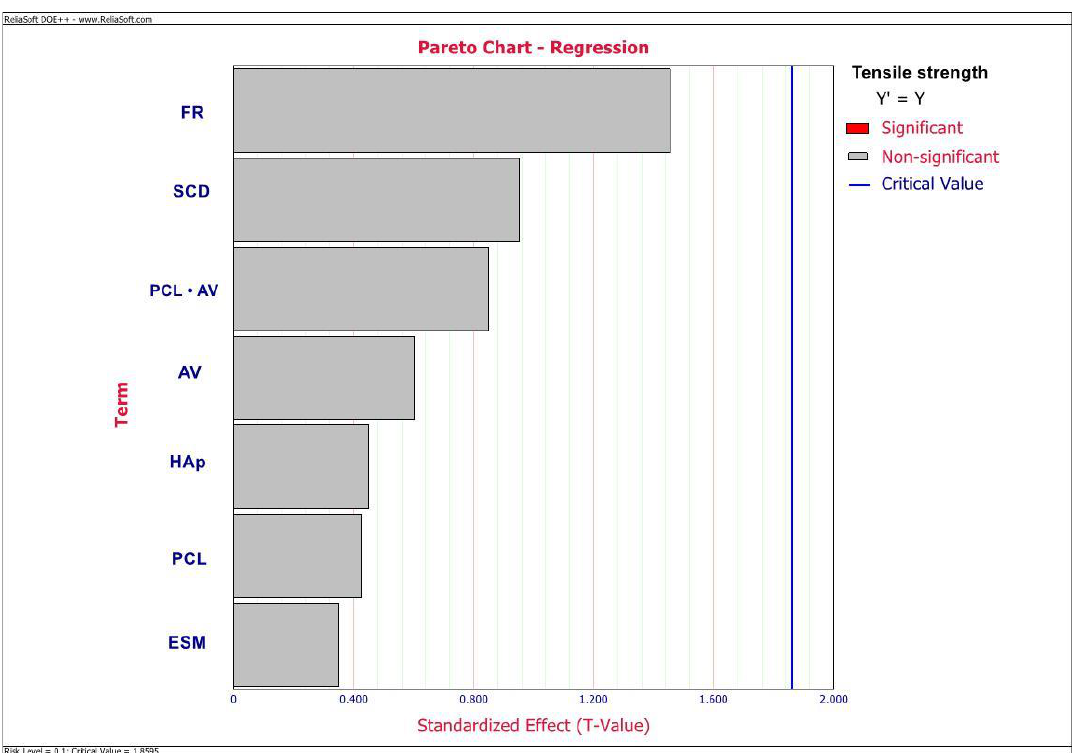
Figure 3. Pareto chart depicting the significant factors affecting TS values of an electrospun composite membrane.